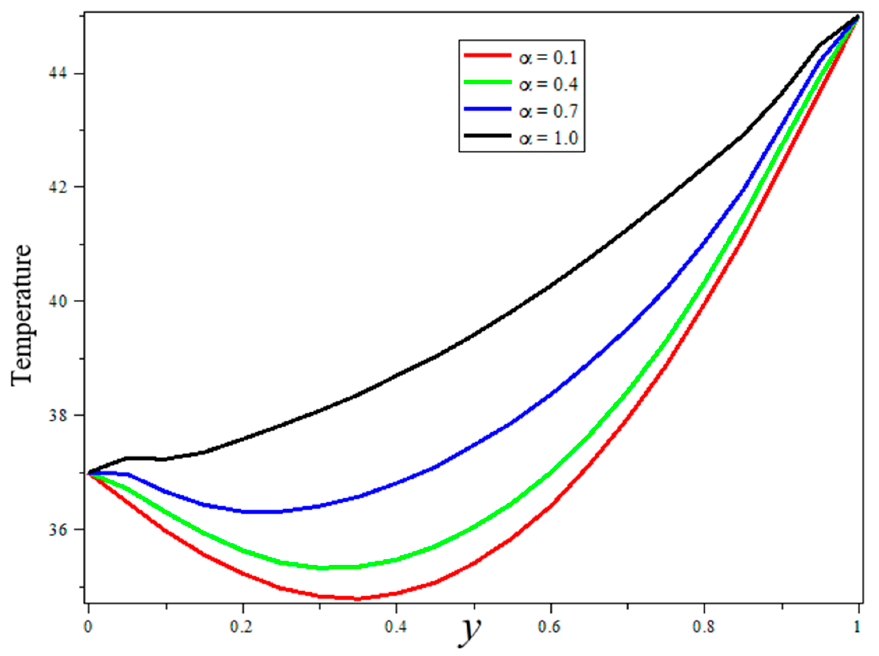
Figure 5. The influence of blood thermal conductivity on the temperature field during tumor hyper- thermia.